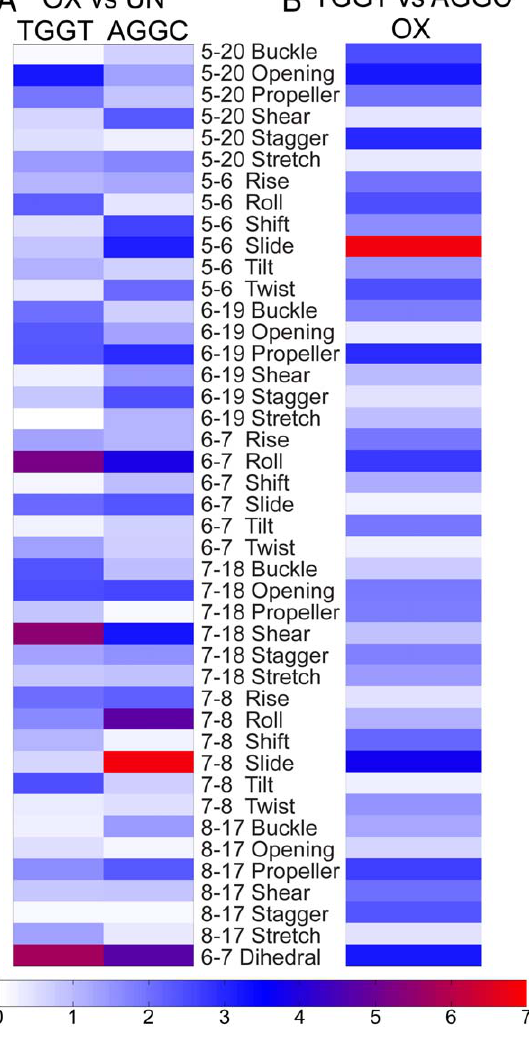
Figure 4. Conformational differences between the NMR structures of OX-DNA and undamaged DNA in the TGGT and AGGC sequence contexts. Heat maps of the Z-scores from comparisons of the 14 lowest energy NMR structures of OX-DNA and undamaged DNA in the TGGT and AGGC sequence contexts (A), and Z-scores of comparisons between the OX-TGGT and OX-AGGC DNA adducts (B).